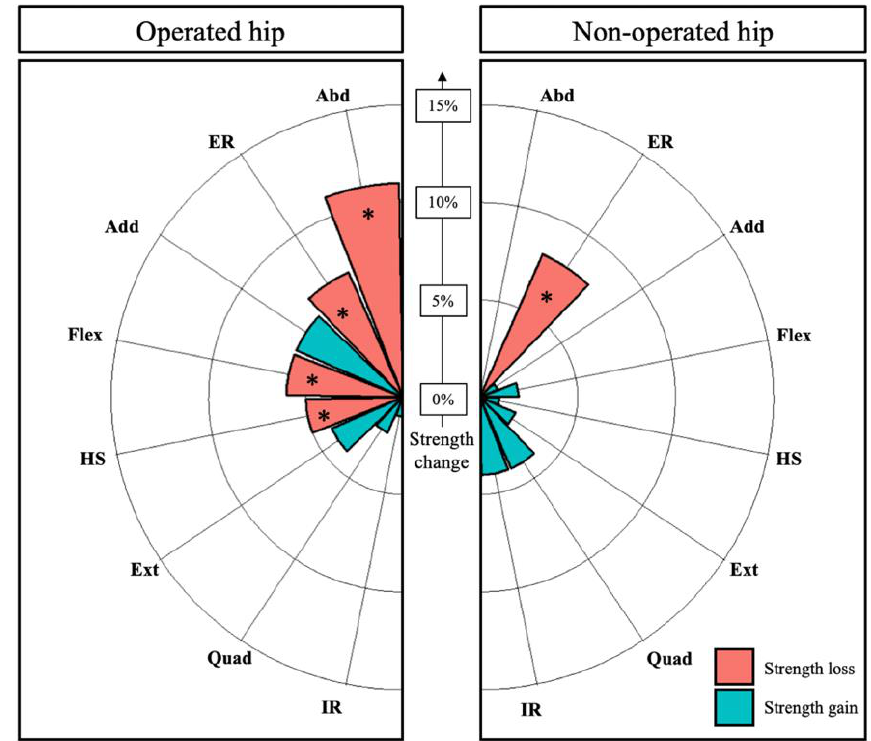
Figure 2. Pre- to postoperative changes in muscle strength (%) on the operated and non-operated hips. * indicates a statistically significant variation. Internal rotators (IR), external rotators (ER), quadriceps (Quad), abductors (Abd), extensor (Ext), hamstrings (HS), flexors (Fl), adductors (Add). The plasty of the acetabulum (n = 16, 55%) and of the AIIS (n = 18, 62%) did not sta- tistically impact the muscle strength changes, probably because subgroup comparisons were statistically underpowered.